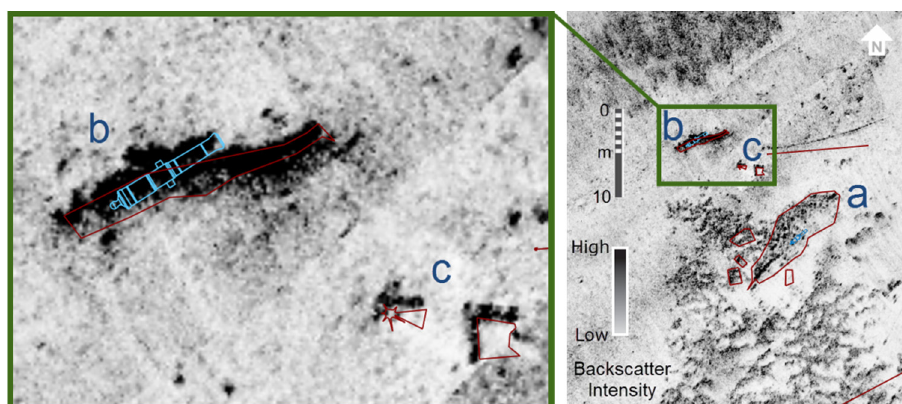
Figure 4. A 3D view of backscatter intensity over ‘wreck site 1’ draped over bathymetry. High backscatter returns ( area A —outlined in red) correspond to the wreck mound ( a ) and archaeological material ( b ) elongated gunwale-like feature; ( c ) steering wheel. Medium and high backscatter re- turns (area A—outlined in red), south and west of the mound, correspond to accumulated sedi- ments. High backscatter returns further south ( area B —outlined in blue) correspond to accumulated sediments in seagrass meadows. Length scale and north arrow refer to the image centre.